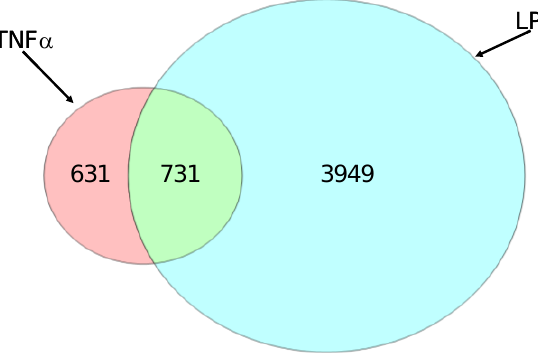
Figure 2. Venn diagram comparing the liver gene expression changes induced by TNFα or LPS treatment (|fold change| ≥ 2.0 and p  0.05). Individual gene expression changes were combined in silico for this